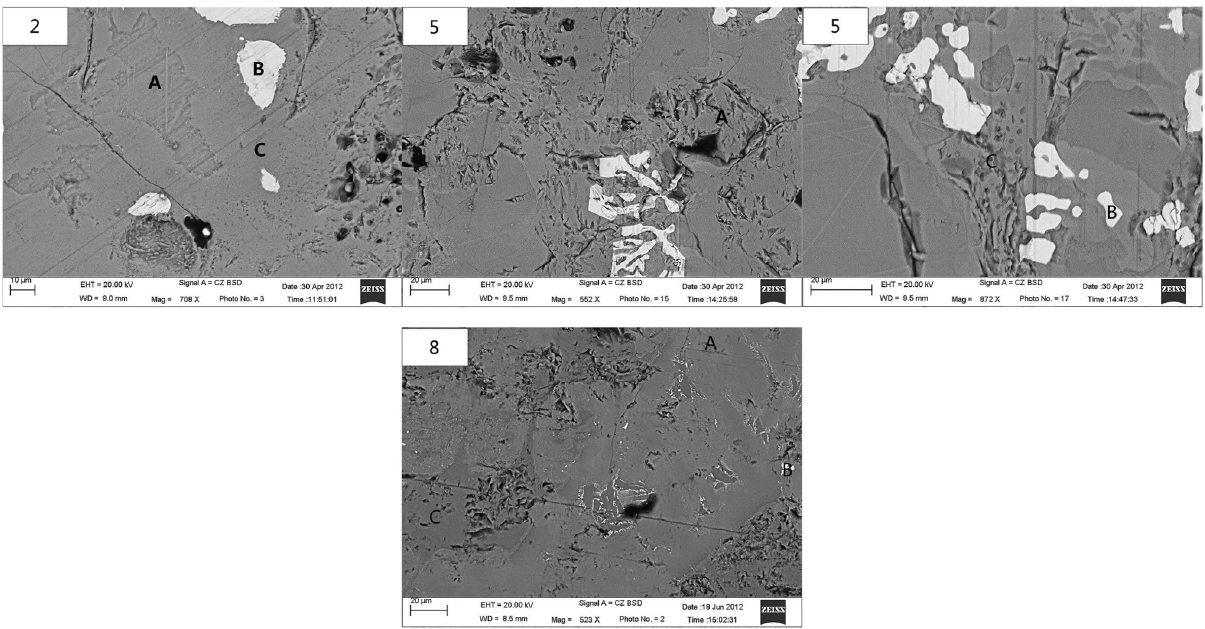
Fig. 4: Scanning electron microscope of sample No. 2, No. 5 and No. 8 (A – phosphorus-enrichment phase, B – metal oxide phase, C – matrix